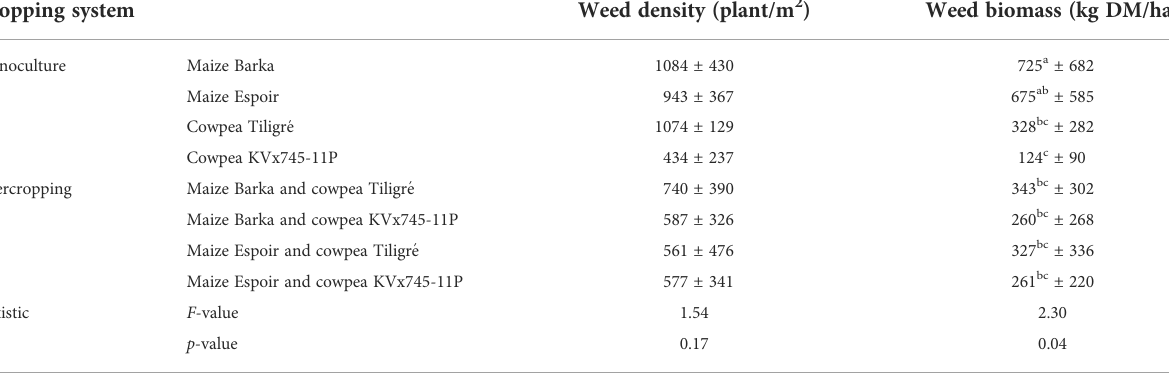
TABLE 5 Weed density and weed biomass (mean and standard deviation) from 2019 and 2020 under maize and cowpea monocultures and intercrops (on-station trial). Cropping system